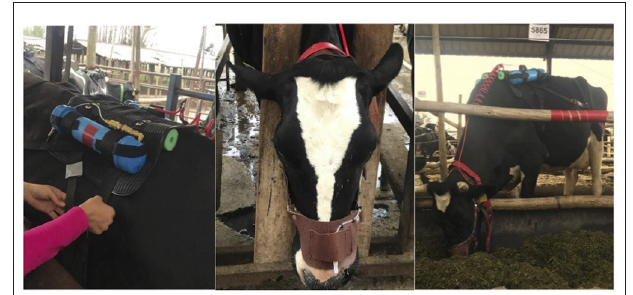
FIGURE 1 | Cow equipped with the sulfur hexafluoride (SF 6 ) equipment to measure enteric methane (CH 4 ) emissions. From left to right: the saddle with PVC canisters; leader head halter, with the sampling point; and the entire